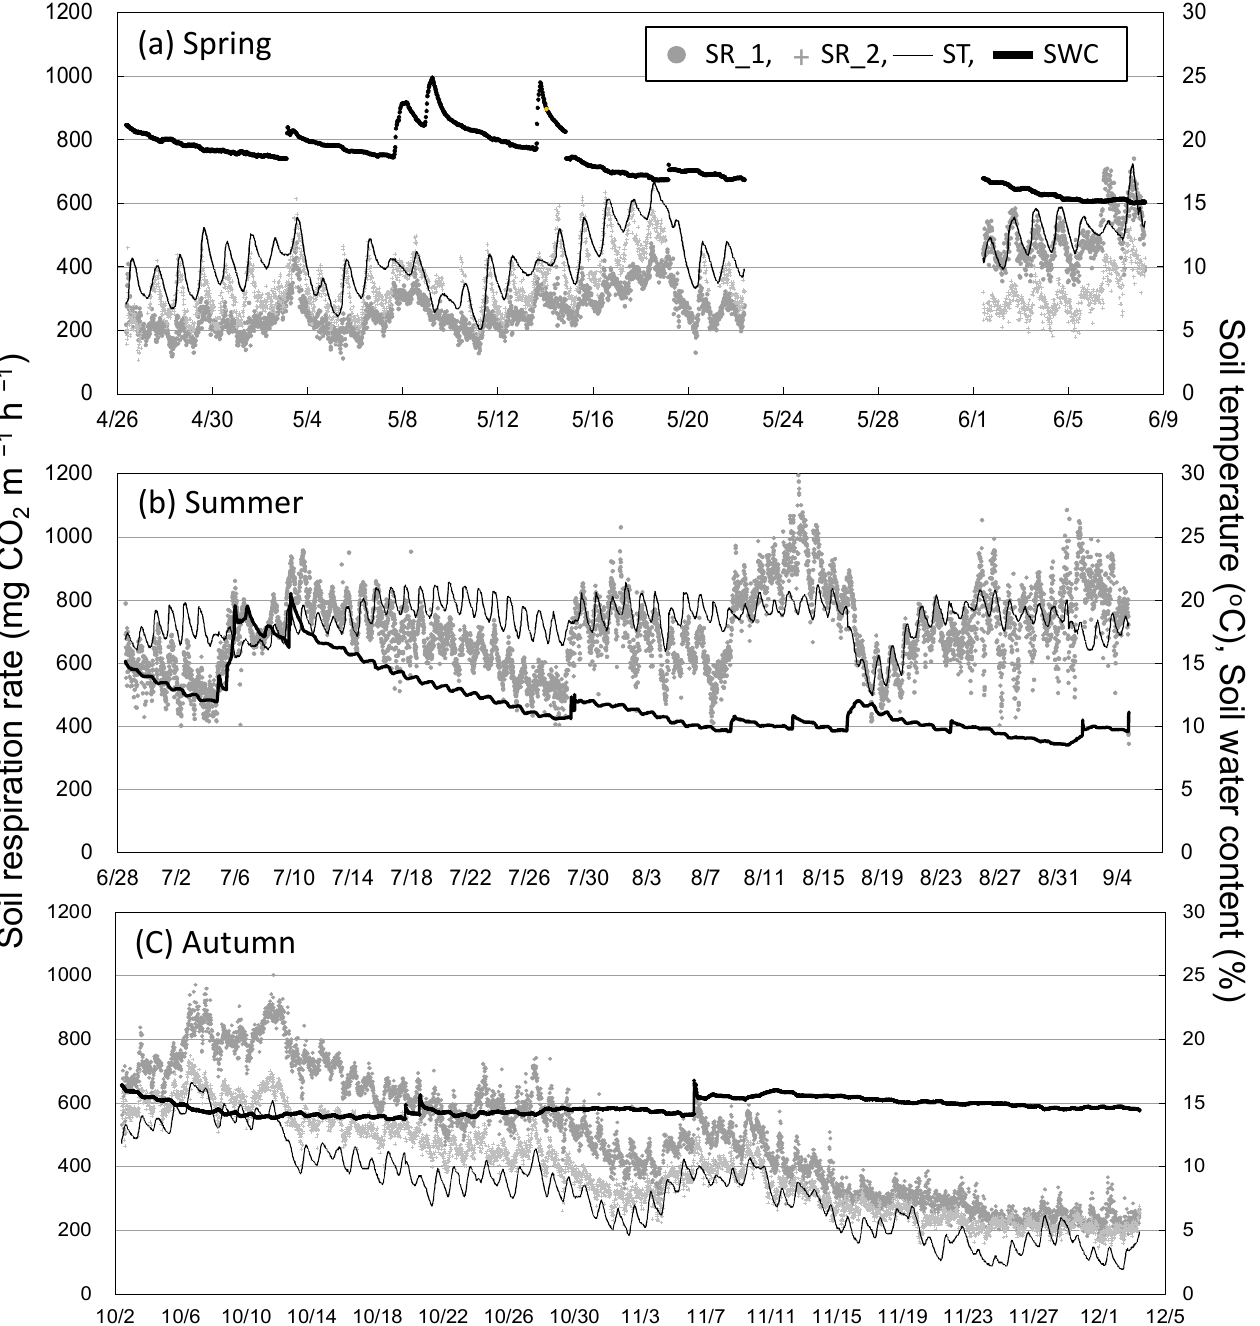
Figure 1. Seasonal variation in soil respiration and environmental factors during ( a ) spring, ( b ) sum- mer, and ( c ) autumn 2018. SR_1 and SR_2, R s in two chambers of R s ; ST, soil temperature at a depth of 5 cm; SWC, soil water content at a depth of 10 cm.